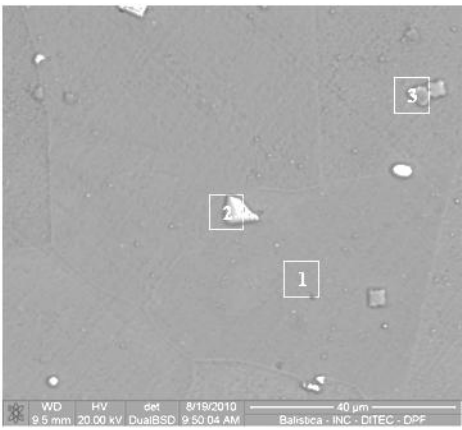
Figure 5. SEM micrograph of heat treated superalloy VAT 32 in backscattered electron mode in which matrix (1) and precipitates (2 and 3) are highlighted. Magnification: 3000×. Matrix chemical composition of VAT 32 (1) is available in Table 1 for this alloy. Precipitates highlighted (2 and 3) were evaluated via EDS with compositions depicted in Table 3 as follows. Table 3. Semi quantitative analysis of precipitates 2 and 3 observed in VAT 32, highlighted in Figure 5.